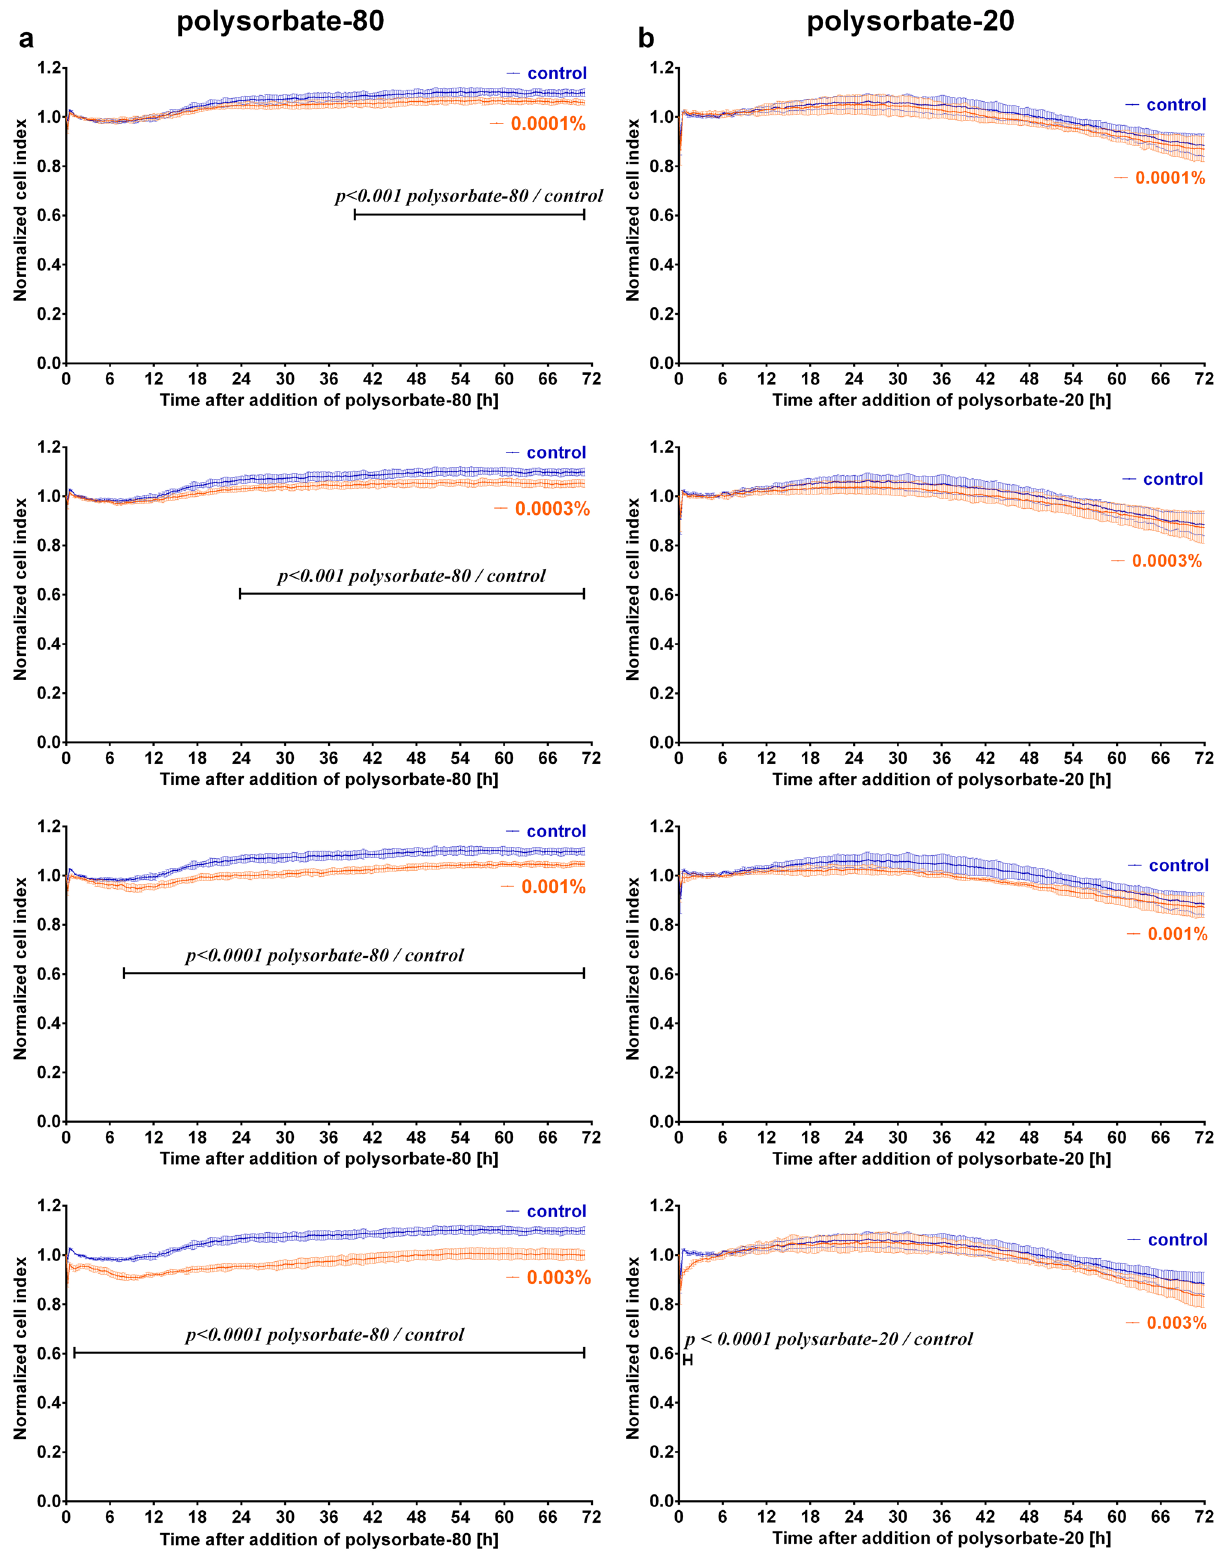
Figure 4. Polysorbate-80 lowered the cell index of iBREC. ( a ) Polysorbate-80 ( n ≥ 6) or ( b ) polysorbate-20 ( n ≥ 6) were added to a confluent monolayer of iBREC cultivated on gold electrodes and the cell index was recorded continuously as a measure of barrier function. Cell index values were normalized in relation to those measured immediately before addition of the detergents and are shown as means with standard deviations. Data were analyzed with two-way ANOVA followed by Sidak’s multiple comparison test. ( a ) Concentrations of polysorbate-80 ≥ 0.0001% significantly and persistently lowered cell index values. ( b ) Polysorbate-20 had no effect on the cell